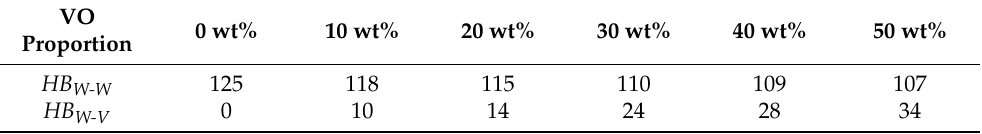
Table 6. The average number of different types of hydrogen bonds at 2 wt% water